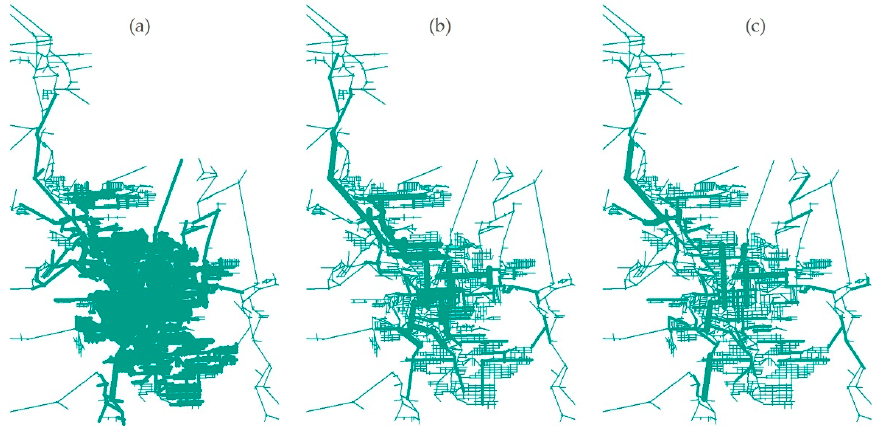
Figure 5. Spatial distribution of centralities for axial lines (dual representation): ( a ) Closeness Centrality; ( b ) Betweenness Centrality; ( c ) Information Centrality. Source: Authors, July 2018.